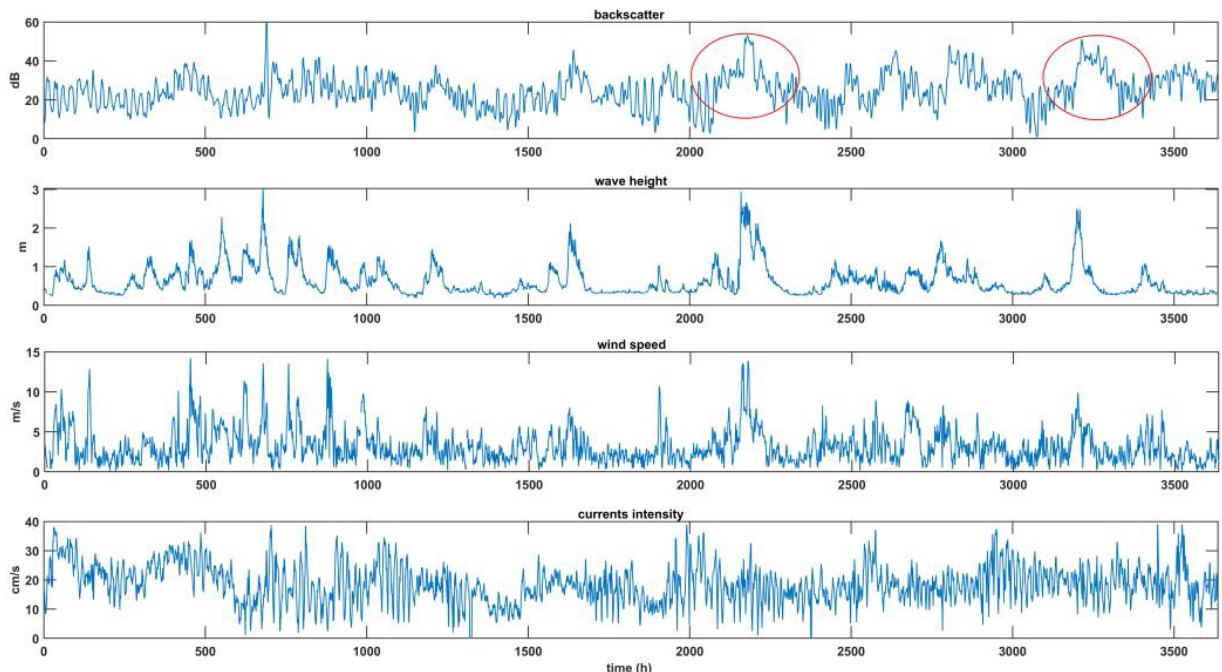
Figure 9. Time series of (top to bottom panels): backscatter strength variation at 8 m depth, wave height, wind speed at 10 m and current intensity at 8 m depth as measured by the observing system W1-M3A. Data were hourly averaged; period of measurements is from 30 March to 29 August 2017. The main effects of the waves on the backscatter are evidenced by red circles.